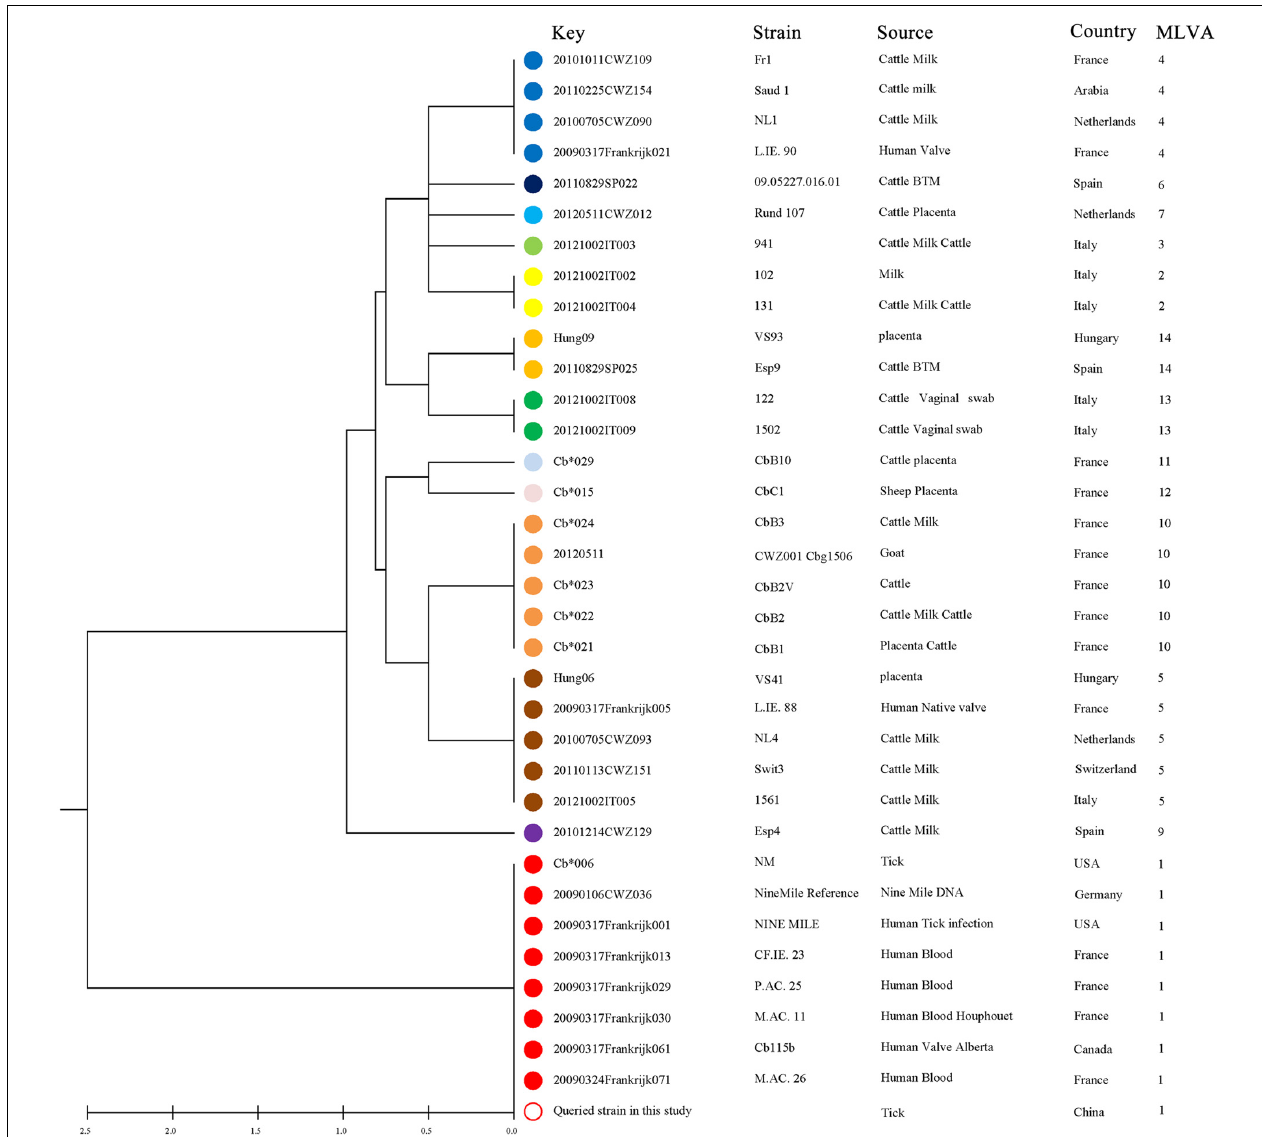
FIGURE 6 | UPGMA cluster analysis of Coxiella burnetii genotypes using a six-multiple locus variable number tandem repeat analysis. All 34 selected samples are based on the MLVA-6 database (http://mlva.i2bc.paris-saclay.fr/mlvav4/genotyping/). The reference strain included in the tree is Nine Mile RSA493. Strain, source, geographical origin, and MLVA-6 type are indicated. The same genotype was coded with the same color. The hollow dots indicate the sample genotype obtained in this study.